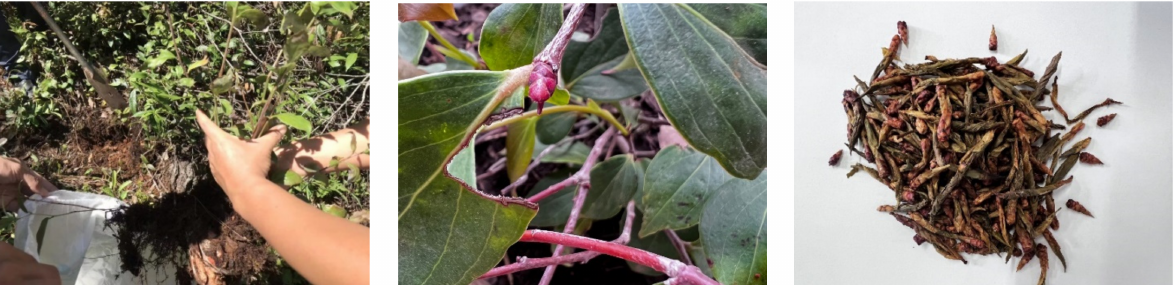
Figure 1. The Vaccinium Dunalianum Wight in nature ( Left ), enlargement with bud ( Middle ), and the “Que Zui tea” collected before extraction ( Right